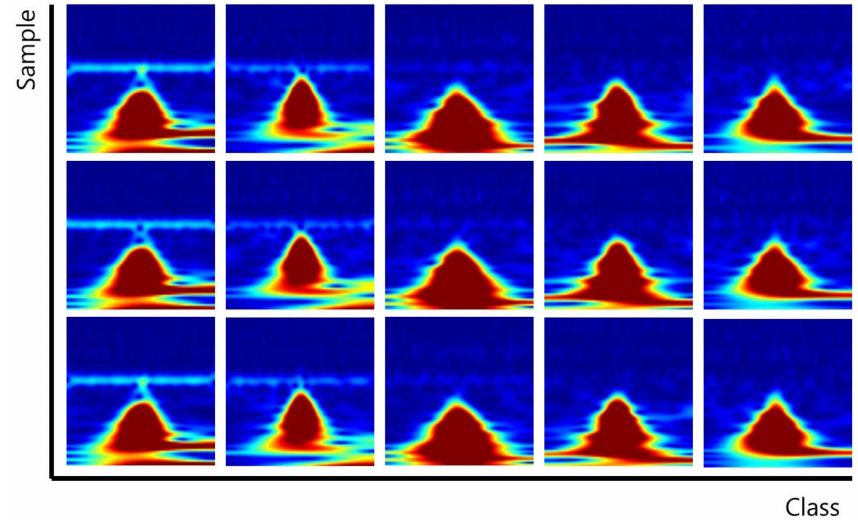
Figure 13. Scalograms of CU-ECG. Table 6. Performance of simple CNN on